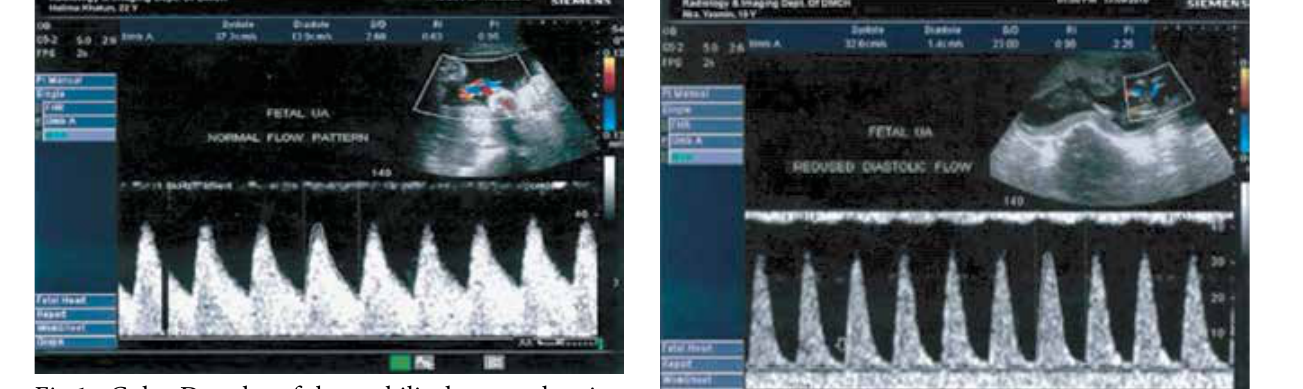
Fig 1. Color Doppler of the umbilical artery showing a normal UA waveform pattern with low impedence, high diastolic flow and decreased pulsatility index